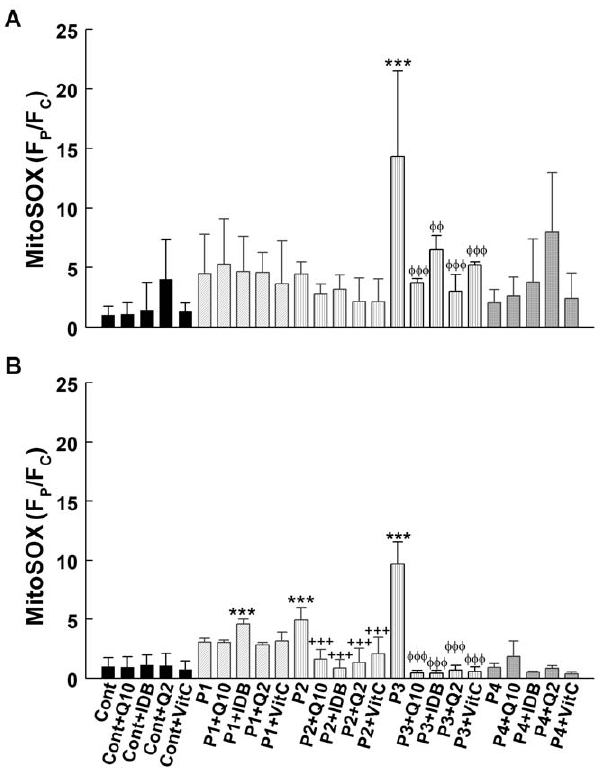
Figure 6. Dead cells after 24 hours (A) or 1 week of treatment (B). Cultured skin fibroblasts from controls and CoQ 10 deficiency patients were treated with 5 m M CoQ 10 , idebenone, CoQ 2 , or vitamin C. After 24 h ( A ) or 1 week ( B ), fibroblasts were collected and Trypan blue assays were performed. Results are expressed as mean 6 SD of three experiments. P1= COQ9 mutant; P2= COQ2 mutant; P3= COQ2 mutant; P4= PDSS2 mutant. * P , 0.05, ** P , 0.01 and *** P , 0.001 compared with untreated control; + P , 0.05 and ++ P , 0.01